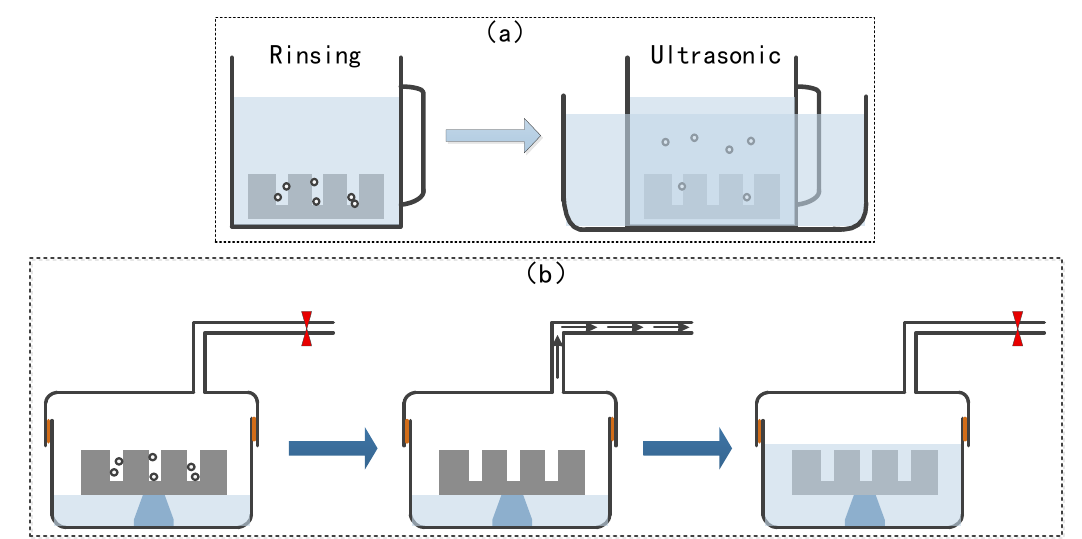
Figure 2. Illustration of pretreatment approaches before plating. ( a ) Rinsing in deionized (DI) water followed by an ultrasonic wave; ( b ) Vacuuming in a sealed environment followed by rinsing in DI water.